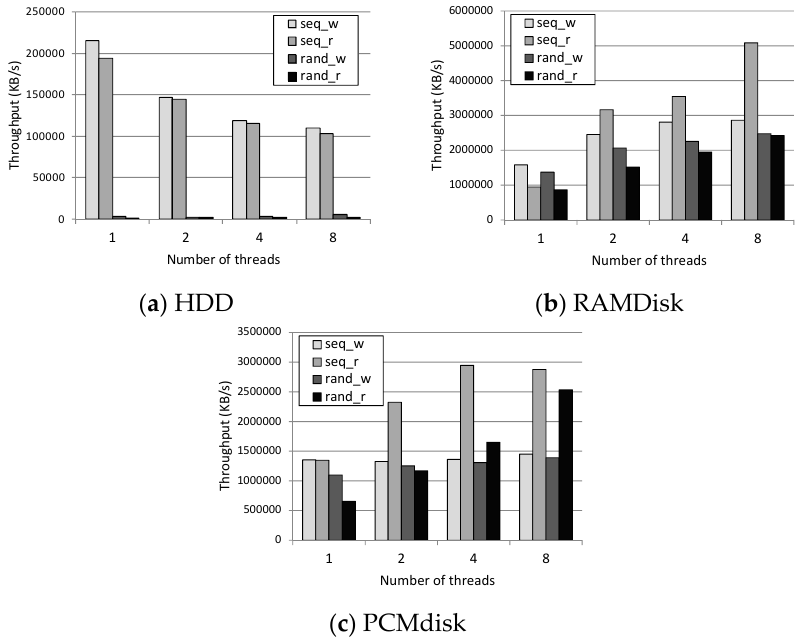
Figure 11. Performance comparison of HDD, RAMDisk, and PCMdisk varying the number of threads.